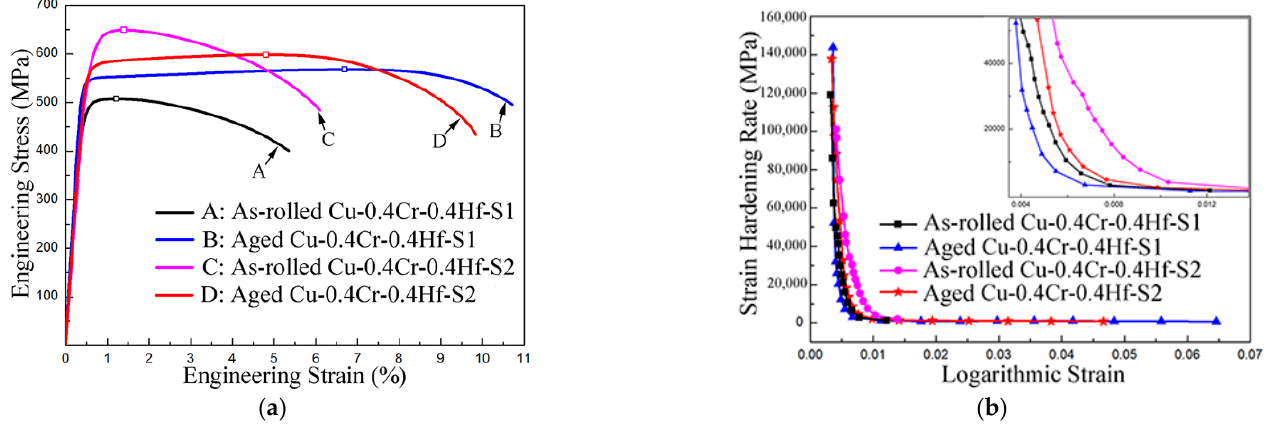
Figure 3. ( a ) Typical tensile curves of the as-rolled and aged Cu-0.4Cr-0.4Hf alloys; ( b ) strain hard- ening rate curves of the as-rolled and aged Cu-0.4Cr-0.4Hf alloys.